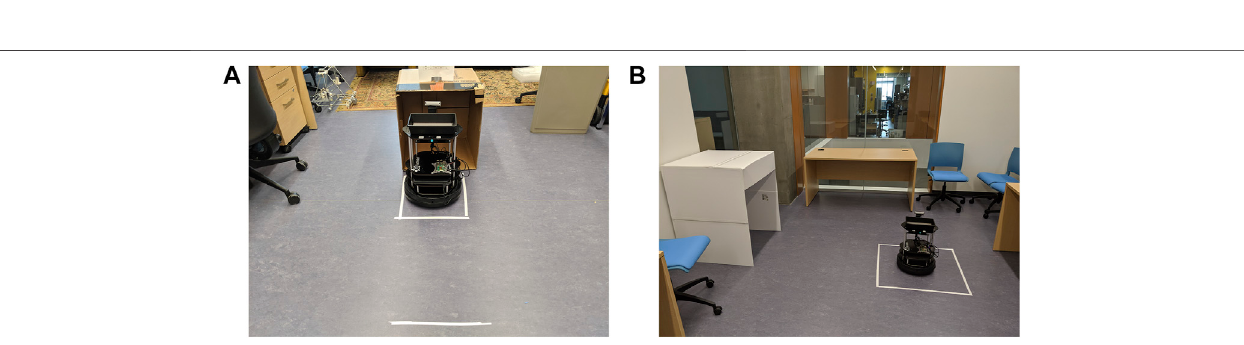
FIGURE 1 | The Human-Robot Interaction Work fl ow. Delivery was triggered and con fi rmed by speech interaction between a visitor and the robot. The robot navigatedtothedeliverytargetwaypoint,withastoptocleantheitemwithUV-Clight.Atthetargetwaypointtherobotusedspeechtocon fi rmdeliveryandthenreturned to its home position. Note that the entire interaction required no physical interaction with surfaces on the robot and, except for placing and retrieving the item in the basket, could be conducted from a distance of as much as several meters away.